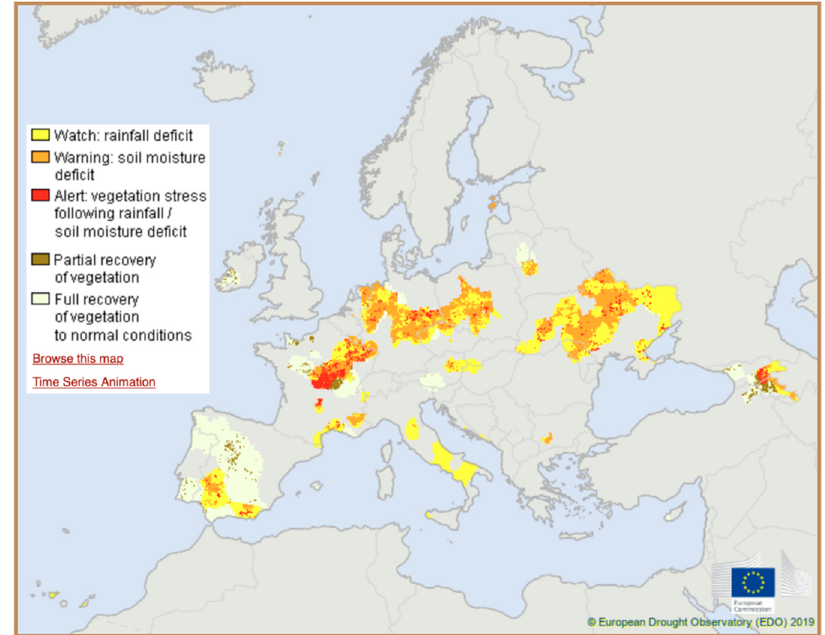
Figure 11. Combined Drought Indicator in Europe for the first 10 days of September 2019. Courtesy of the European Drought Observatory (https://edo.jrc.ec.europa.eu/edov2/php/index.php?id=1000, last accessed 24 September 2019) [302].